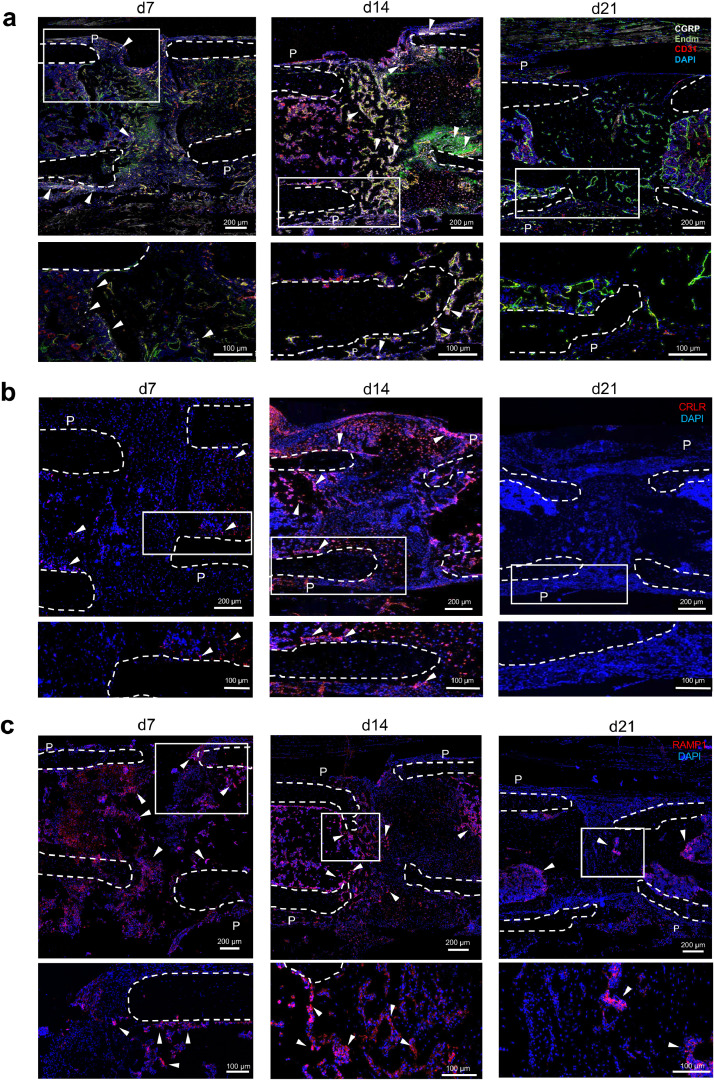
CGRP and CGRP receptor are expressed in the fracture callus on protein level. (a) Representative immunofluorescent stainings (merged) of WT callus sections 7, 14, and 21 days after surgery using a CGRP-, endomucin- (Edm) and CD31-specific antibody. (b, c) Representative immunofluorescent stainings of WT callus sections 7, 14 and 21 days after surgery using a CRLR or RAMP1-specific antibody as indicated. P = periosteum. White boxes of the upper row show the magnified area illustrated below. Arrows indicate CGRP-, CRLR- orRAMP1-positive structures, respectively, and dotted white line show the fracture ends.